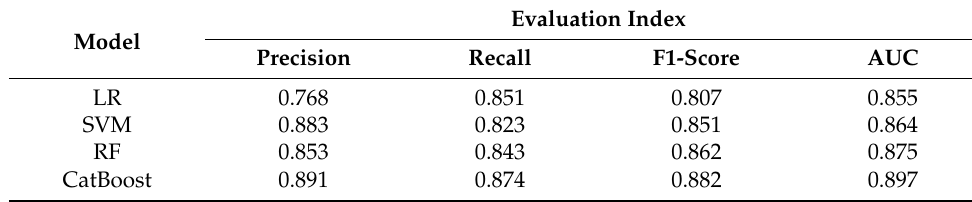
Table 8. Experimental results of different models.